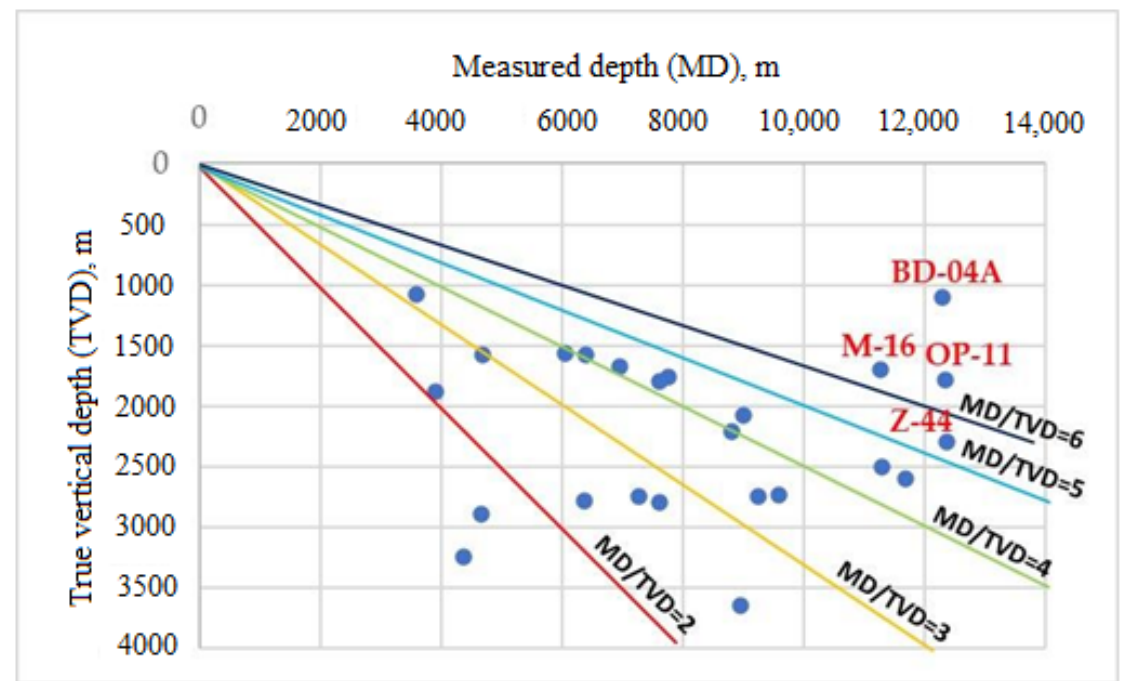
Figure 2. The ratio of measured depth vs. the true vertical depth and reach for wells such as BD-04, M-16, OP-11 and Z-44 and other wells presented in Table 2.